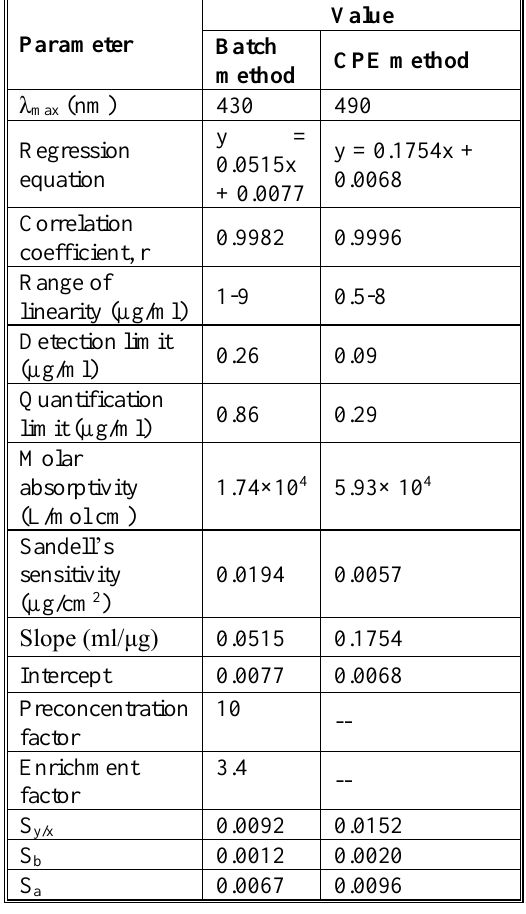
Table 2. Analytical characteristics for suggested method with and without